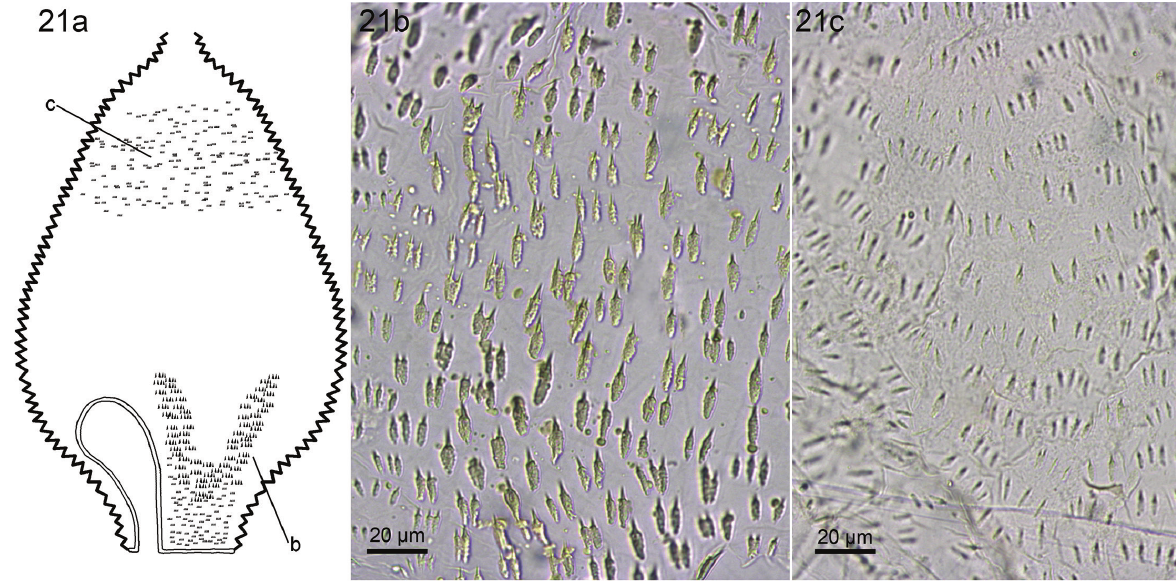
Figure 21. Rhynchotermes perarmatus . (a) Schematic drawing of P1 showing arrangement of spines. (b, c) Photomicrographs: (b) Detail of spines with strongly sclerotized base next to mesenteric tongue; (c) Detail of rows of small spines in the distal region.